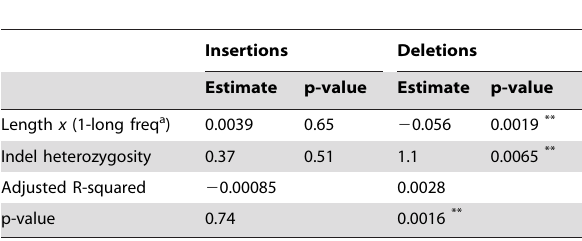
Table 7. Correlation between sample frequency and distance to closest coding